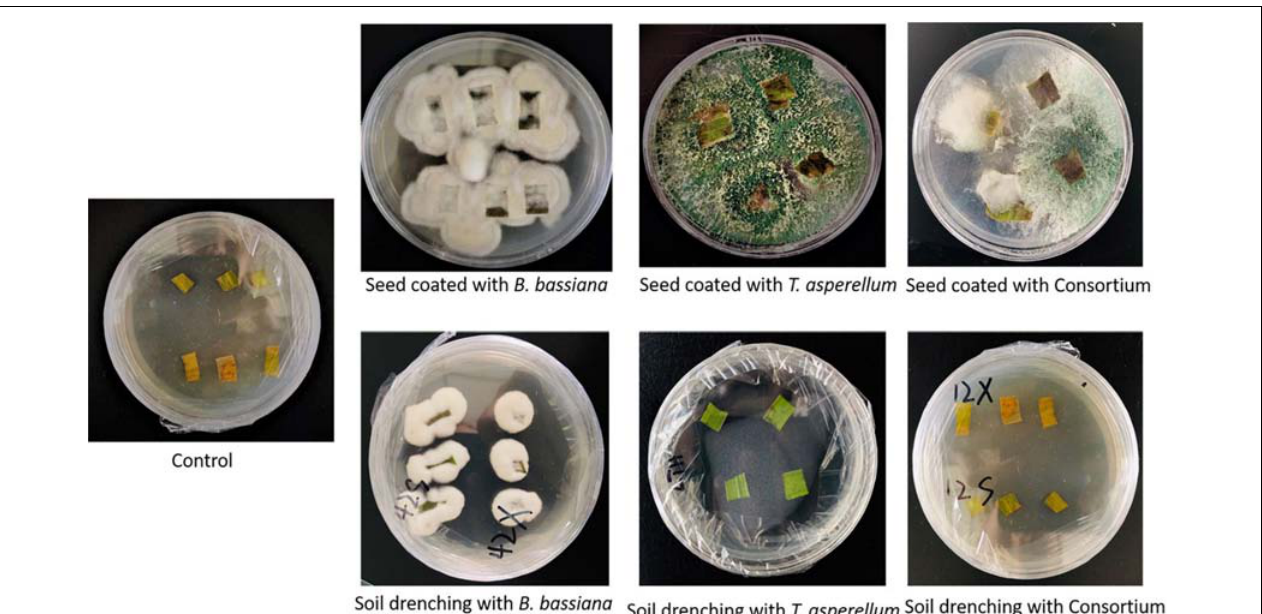
FIGURE 1 | Confirmation of endophytic colonization of plants by fungal isolates through the re-isolation method. TABLE 2 | Differential effect of single and consortium of B. bassiana OFDH1-5 and T. asperellum GDFS1009 inoculation on larval survival rate, number, and length of tunnels under O. furnacalis attack for two generations in 2018 and 2019. Treatments Mortality (%) Number of tunnels/plant Length of tunnels (cm)